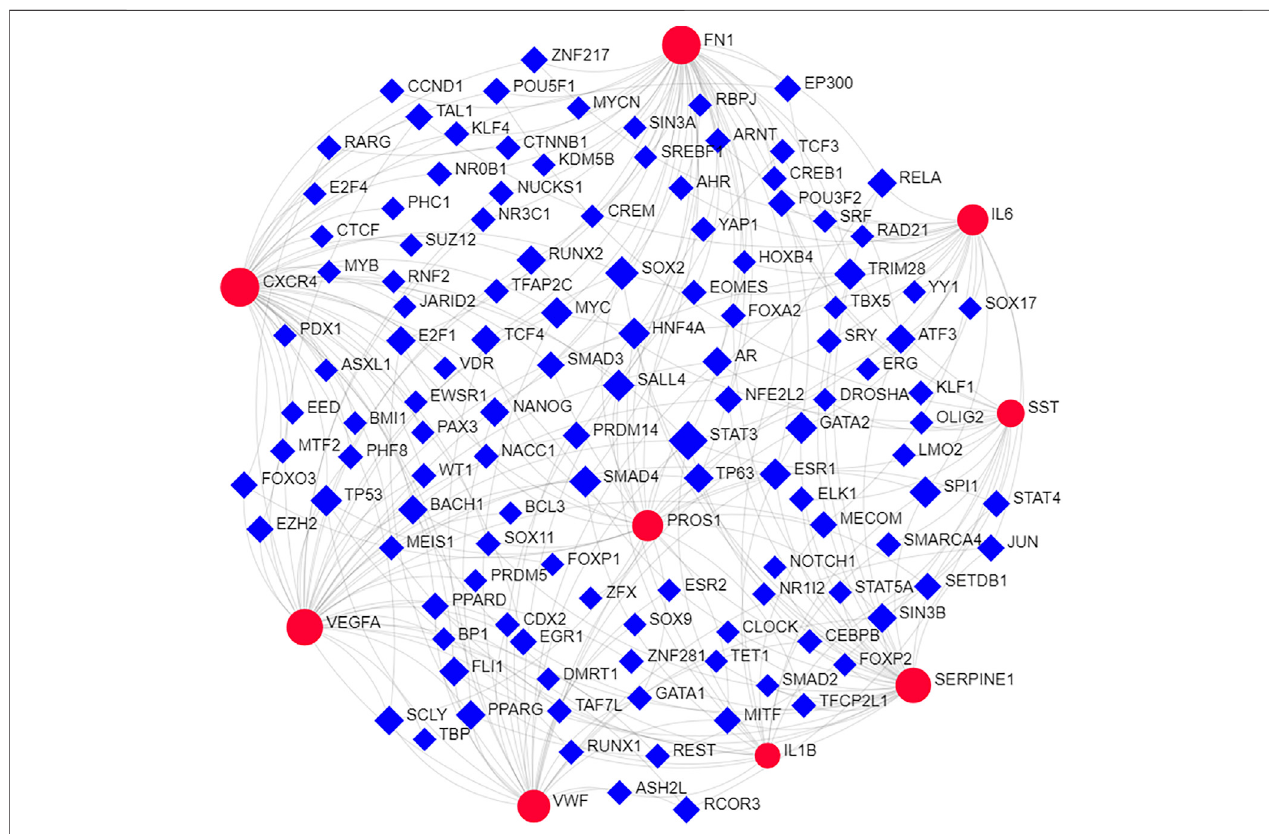
FIGURE 5 | The interactions of hub genes with TFs. The TFs regulatory network of nine hub genes. Red nodes represented nine hub genes and blue squares represented TFs.